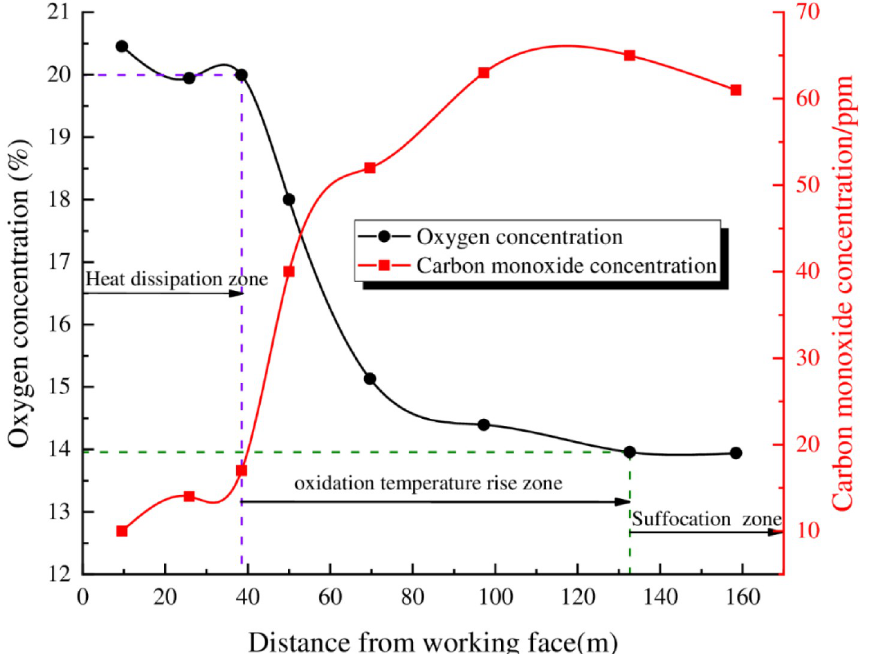
Fig 10. Distribution of O 2 and CO at different locations in the